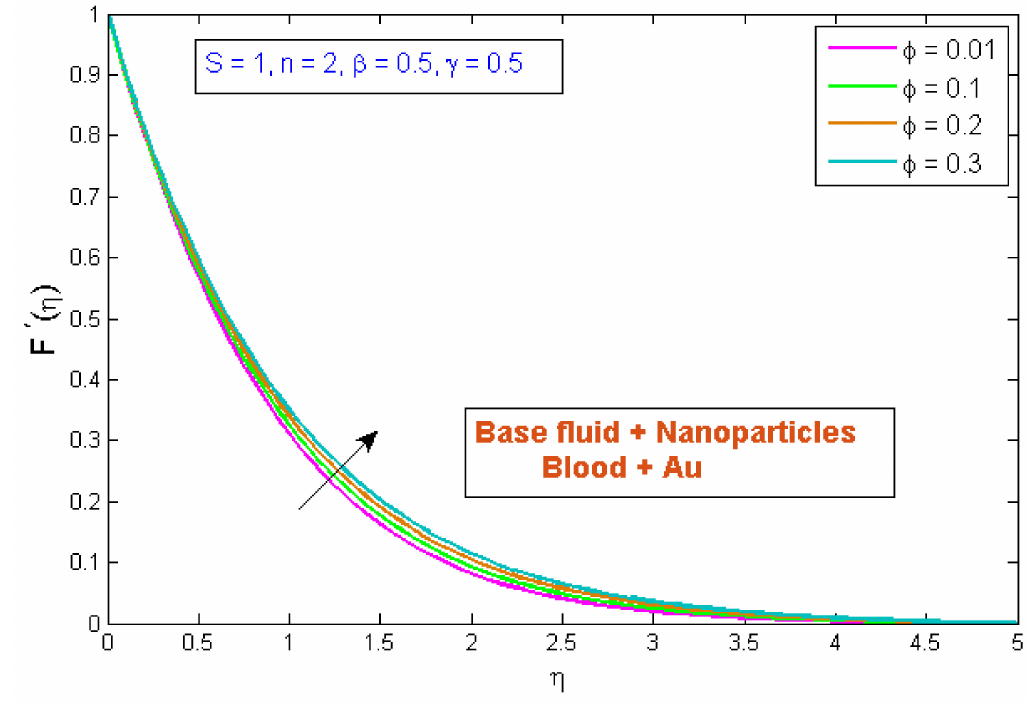
Figure 2. Modification of F (cid:48) ( η ) versus φ .